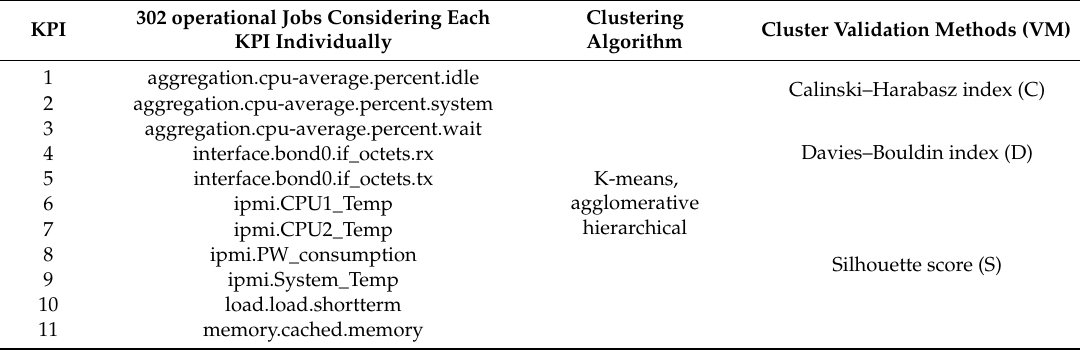
Table 7. Experiment two